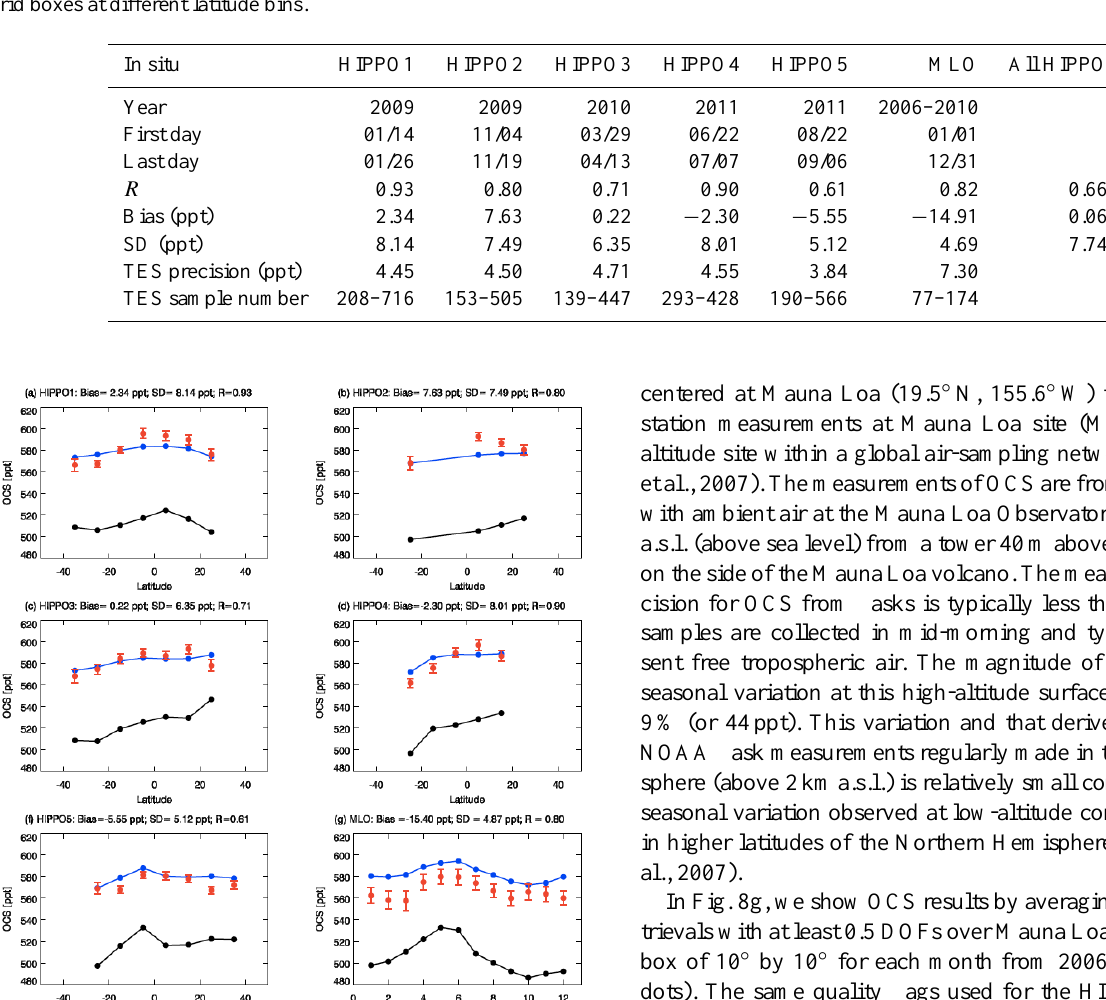
Table 1. List of the HIPPO measurement period, correlation coefficient, bias, SD, TES precision and sample number for the comparisons between TES multiyear monthly data and in situ data. The sample values listed here are the range of the numbers of TES retrievals in the grid boxes at different latitude bins.